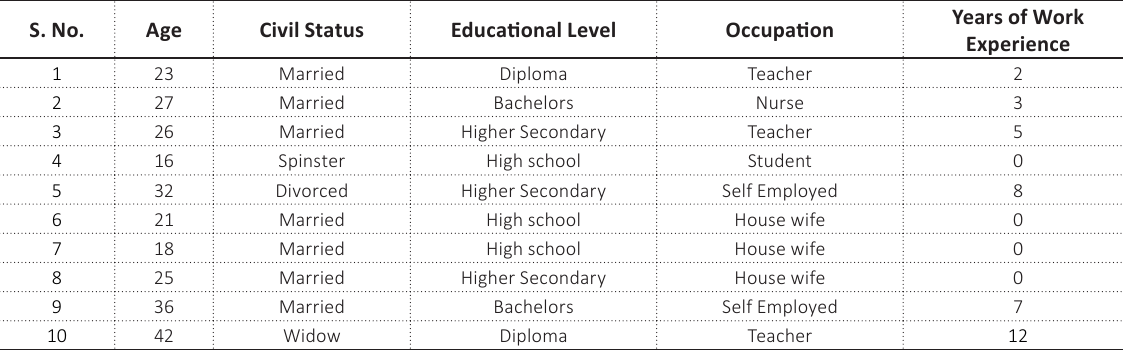
Table 1. Demographic profile of interview respondents S.